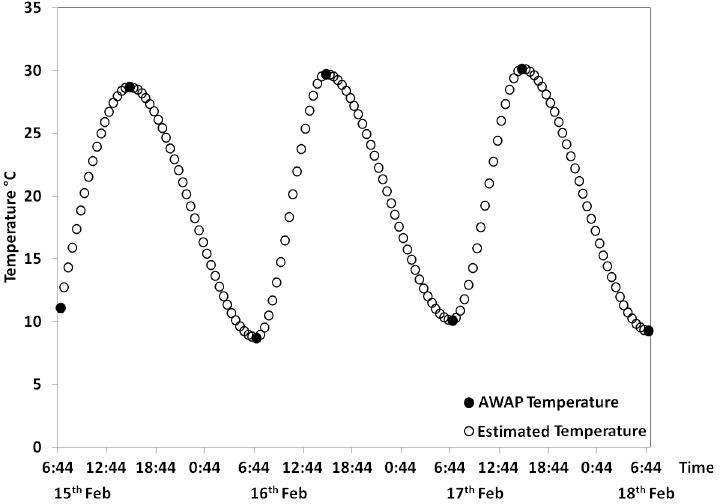
from the 1995 – 96 growing season.